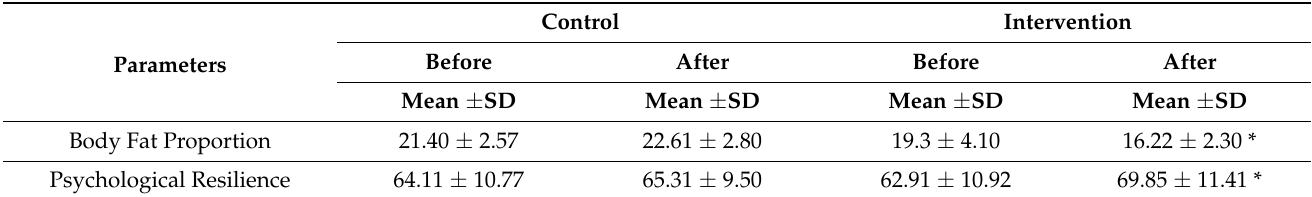
Table 3. Comparisons of body fat composition and psychological resilience between the intervention and control